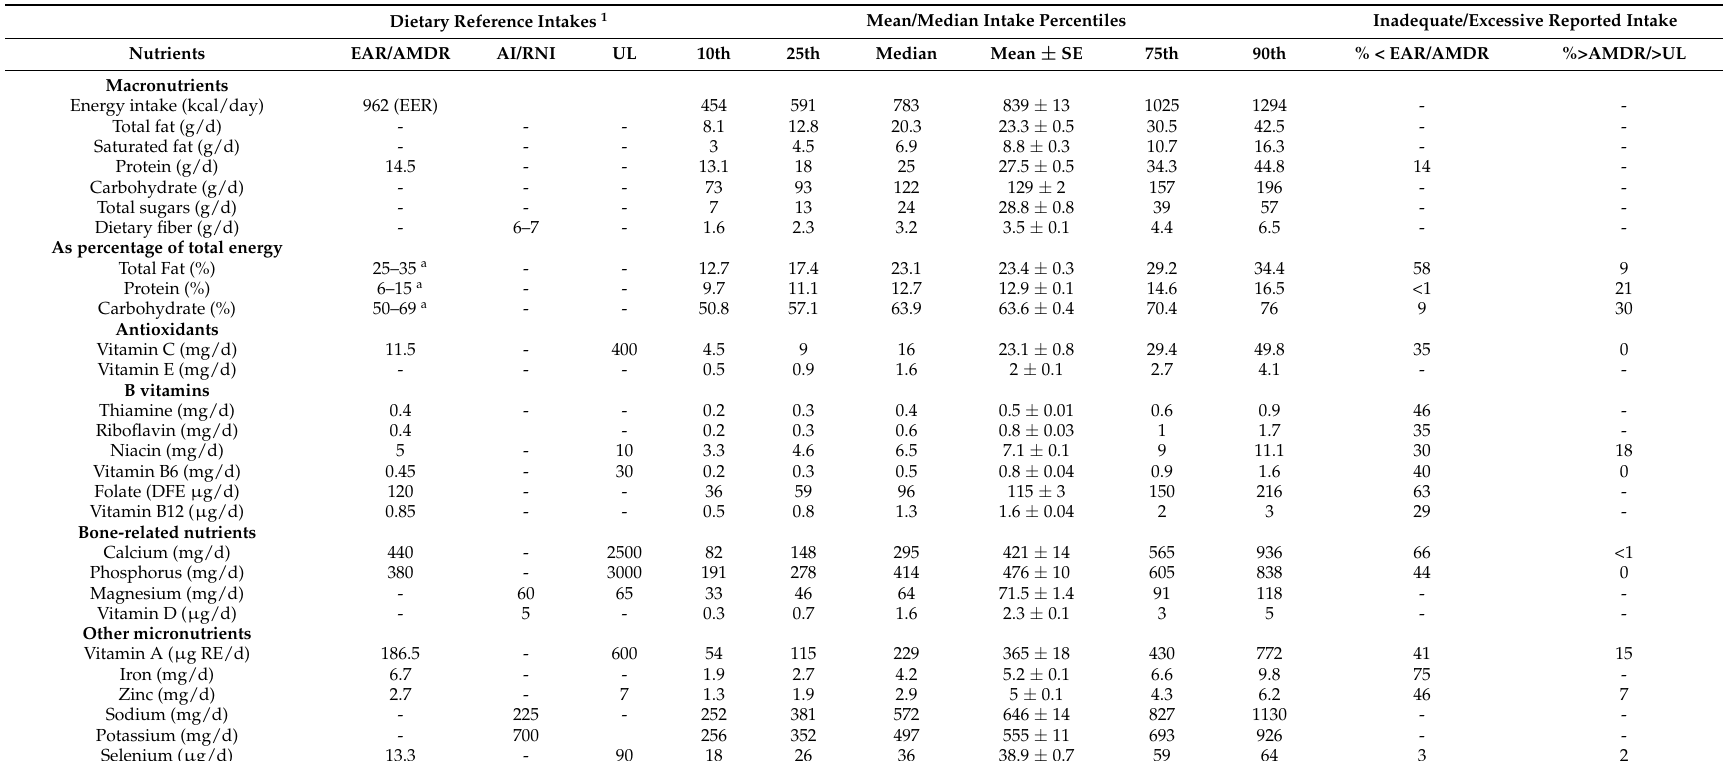
Table 7. Usual energy and nutrient intakes from food and beverages for Filipino toddlers aged 24–35.9 months ( n =